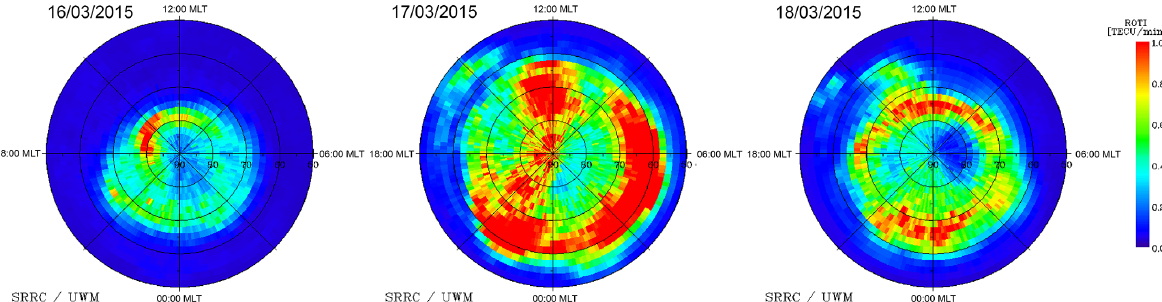
Figure 11. The polar ROTI maps for the St. Patrick’s Day storm period (16 to 18 March).